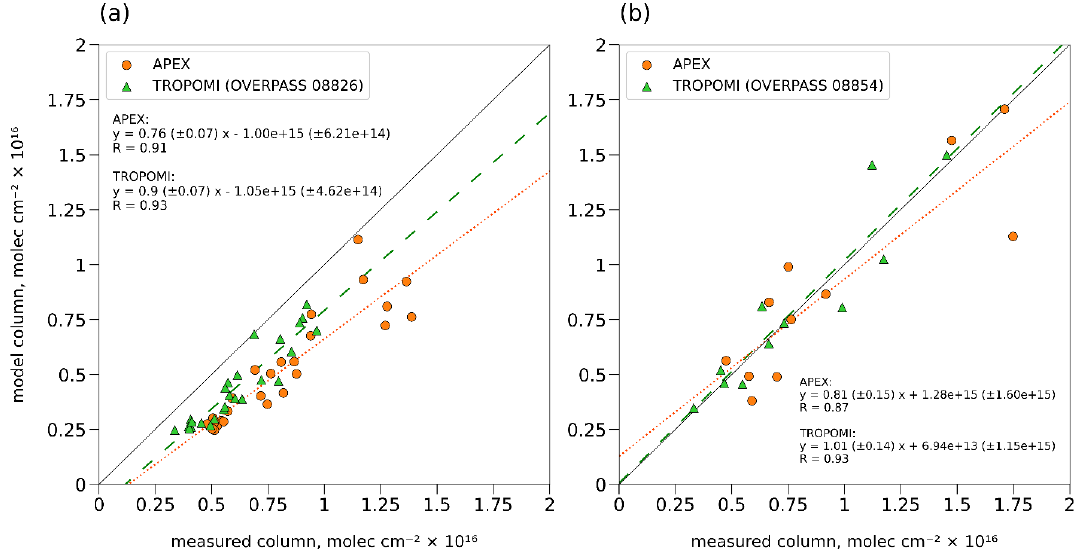
Figure 19. Scatterplots and linear regressions of modeled vs. measured columns (APEX and TROPOMI_v1.3) on (a) 27 June and (b) 29 June. Orange dots and dotted regression lines are for APEX and green triangles and lines for